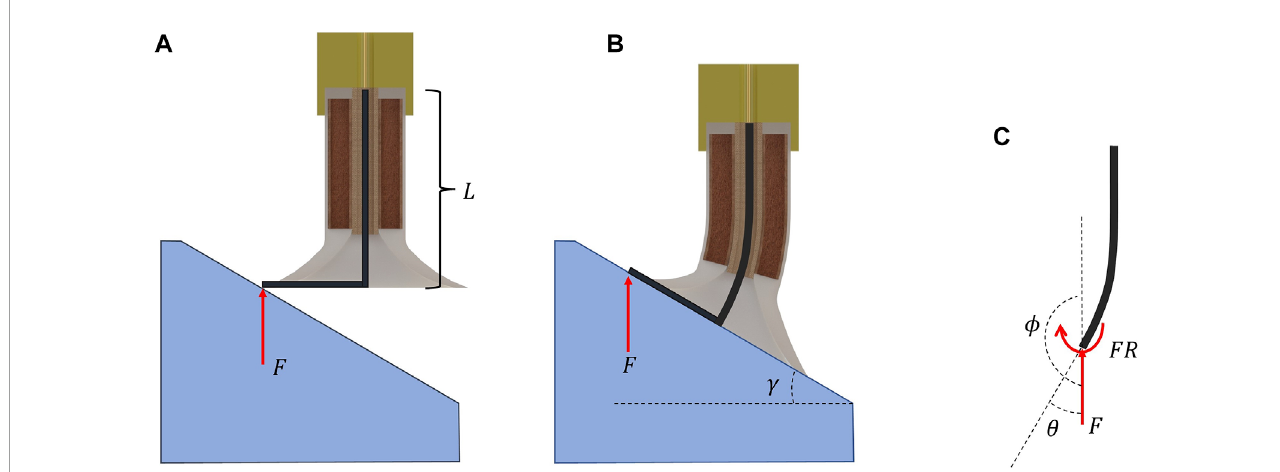
FIGURE 3 The L-beam used to model the behavior of the suction cup during the adaptation. (A) the initial shape of the beam and the suction cup. (B) The deformed suction cup with the deformed L-shape beam. (C) the free body diagram (FBD) of the stalk, here F is the required force for adaptation, γ is the surface angle, θ is the tip deflection, ϕ is the angle between the force and stalk which in this case is 180 ° , and also a moment relative to the force and the radius of the suction pad is also applied to the beam.